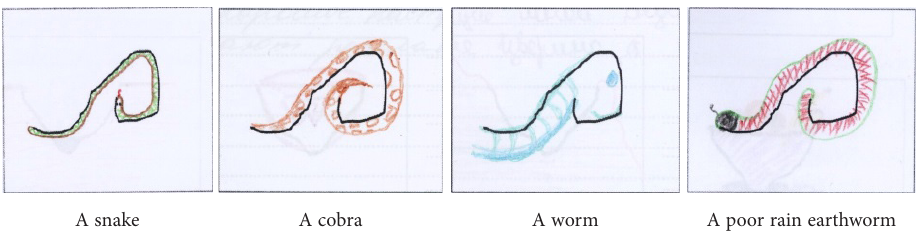
Figure 9. The creative task: interpretation of Fragment 2 – animals: crawling creatures (source: testingmom.com, 2020) Creatures that remind us of several kinds of animals made up about one fifth of interpre- tations (17% or 8 out 48): a butterfly was mentioned twice (Lithuania, Latvia) as well as an elephant (Latvia, Belarus), a unicellular organism (Slovenia), a horse (Belarus), a black cat (Lithuania) and “a mysterious animal” (Estonia) were mentioned once (Figure 10).